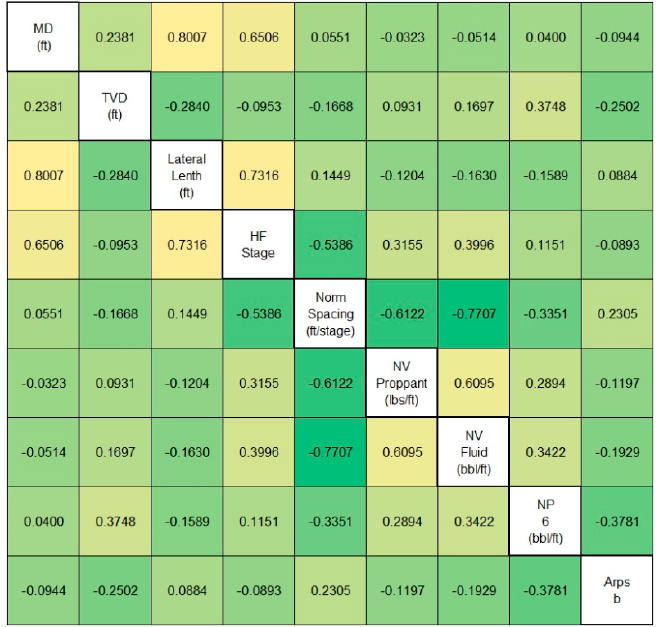
Figure 8. Correlation coefficients among input attributes. Table 3. List of acquired attributes in this